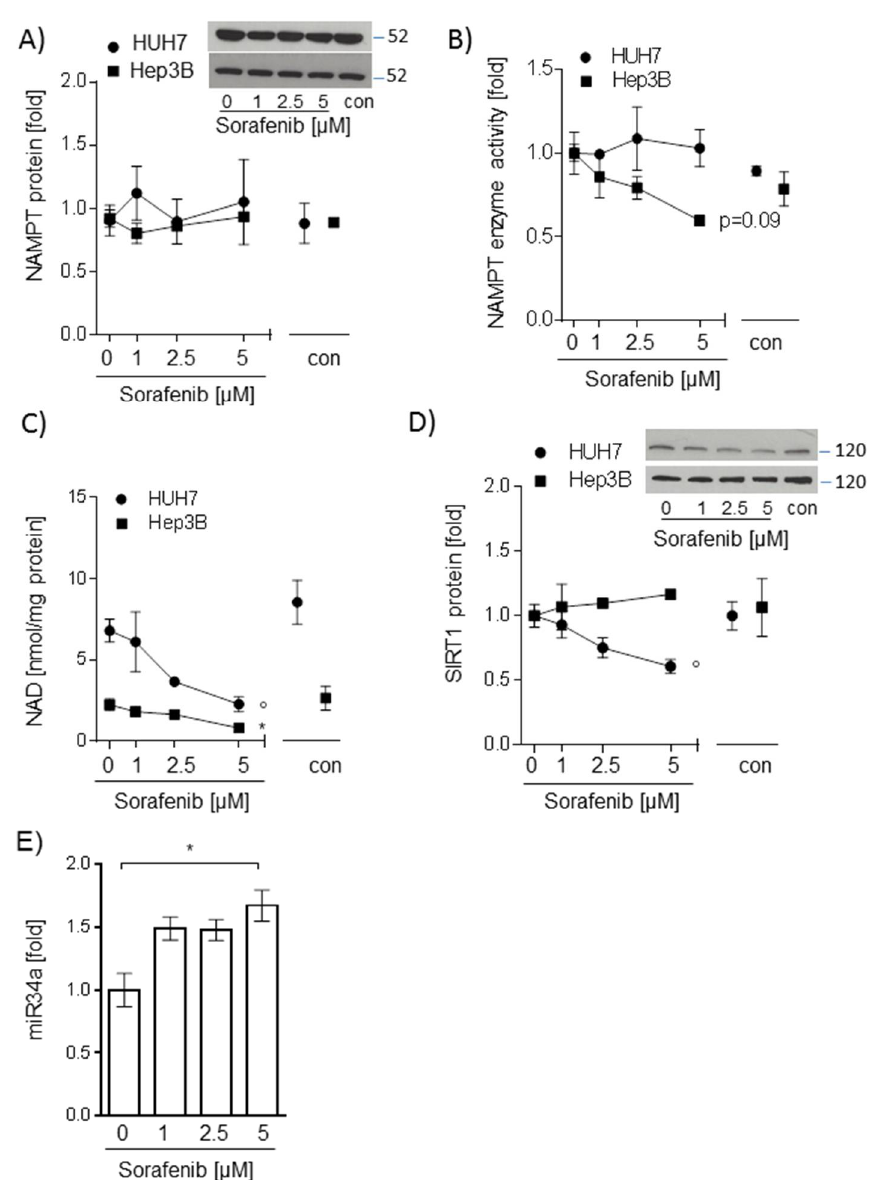
Figure 2. Sorafenib-induced decrease of nicotinamide adenine dinucleotide (NAD) levels in hepatocarcinoma cells is not mediated by nicotinamide phosphoribosyltransferase (NAMPT) or sirtuin (SIRT1) NAMPT ( A ), and SIRT1 ( D ) protein were analyzed by Western blot analysis. NAMPT and SIRT1 protein were normalized to glyceraldehyde-3-phosphate dehydrogenase (GAPDH) (not shown). One representative blot out of three experiments is shown as an insert. Densitometric analysis was performed to semi-quantify values ( n = 3). ( B ) Intracellular NAMPT enzyme activity was determined by measuring the conversion of 14 C-labeled nicotinamide to 14 C-NMN ( n = 3). ( C ) Intracellular NAD levels were measured by gradient HPLC / UV analysis ( n = 3). ( E ) Expression of miRNA34a was measured using miScript primer assays for miR34a-1 and normalized to Hs_RNU6_2_1 ( n = 3). For all experiments, HUH7 and Hep3B cells were stimulated with sorafenib (1 µ M; 2.5 µ M, and 5 µ M) for 24 h. The mean value of serum-free medium (0 µ M) was used to normalize values of the respective datasets. Data are shown as mean ± SEM. con: solvent control (DMSO); ◦ p < 0.05 (HUH7); * p < 0.05 (Hep3B).